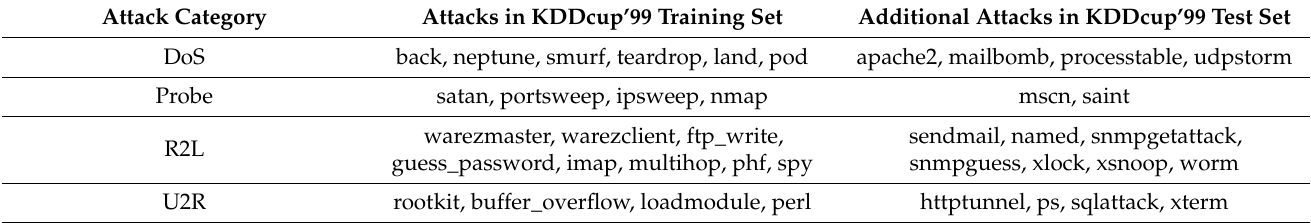
Table 4. Detailed attack types on the training set and test set on KDDcup’99.